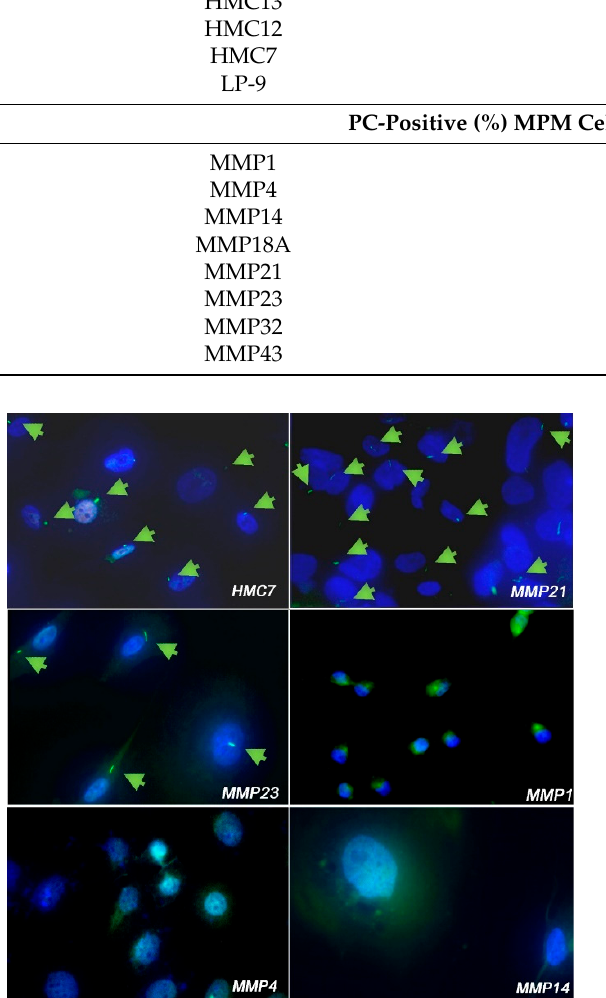
Figure 2. IF analysis of PC expression in selected primary MPM and non-tumoral mesothelial cell lines. PC-positive cell lines: HMC7 normal mesothelial, MMP21, MMP23; PC-negative cell lines: MMP1, MMP4, MMP14. blue: dapi; green: Arl13b. Magnification 20×. Primary cilia are indicated with arrows.